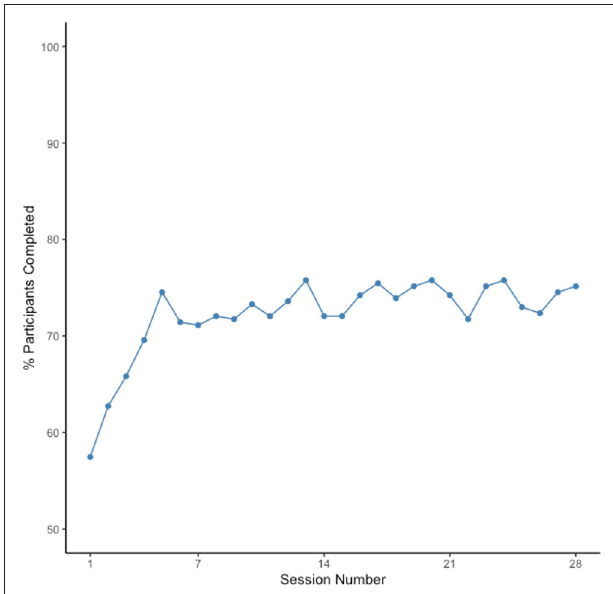
FIGURE 7 | Percentage of participants who completed each of the 28 ARC